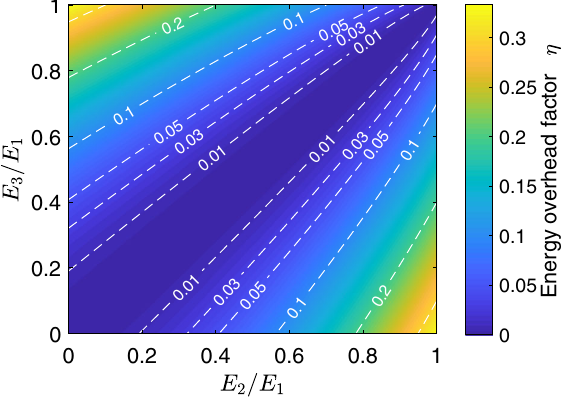
FIG. 5. Energy overhead factor for different beam energy combinations of the other two undulator lines with the condition of E 0 ¼ E 1 = 2